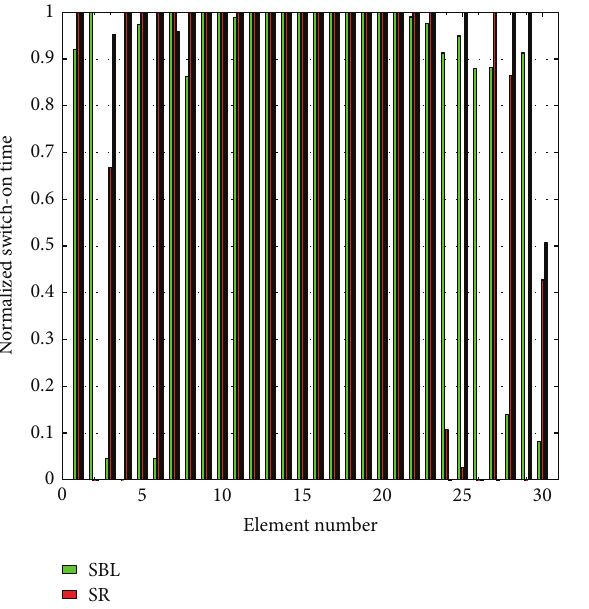
Figure 19: Switch-on time durations of the best converged solution for JSCIS.